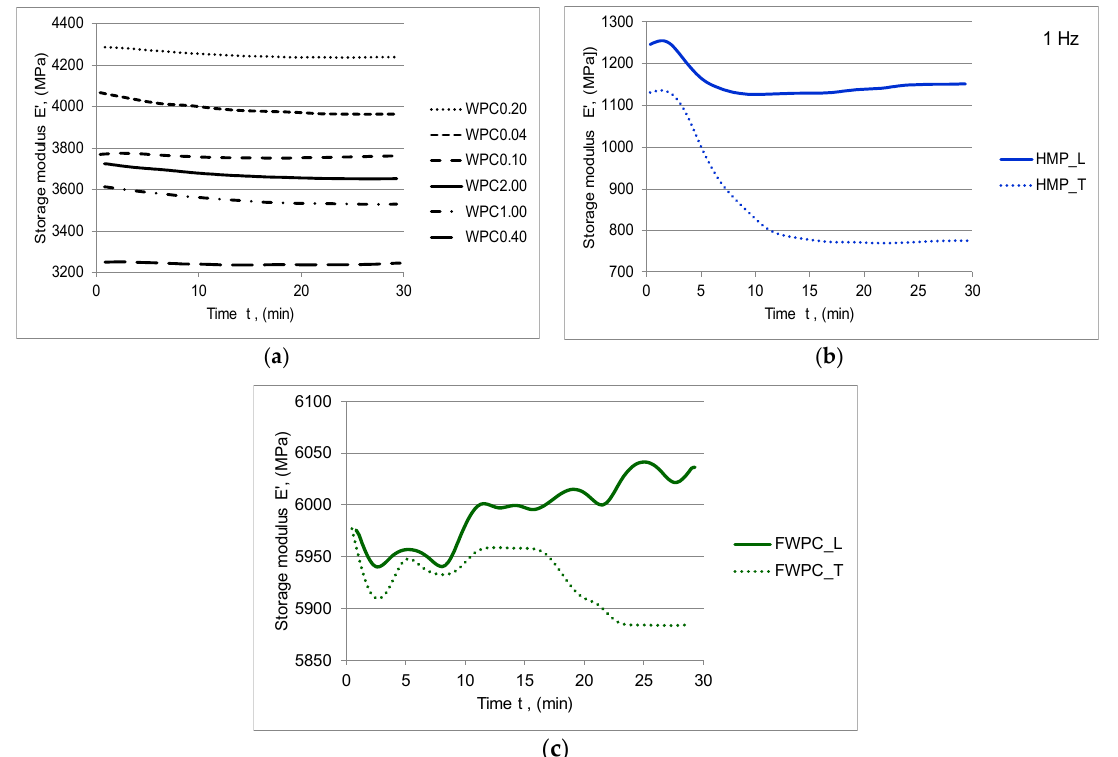
Figure 9. Variation of the storage modulus E’ in time: ( a ) WPC samples; ( b ) HMP samples; ( c ) FWCP samples.